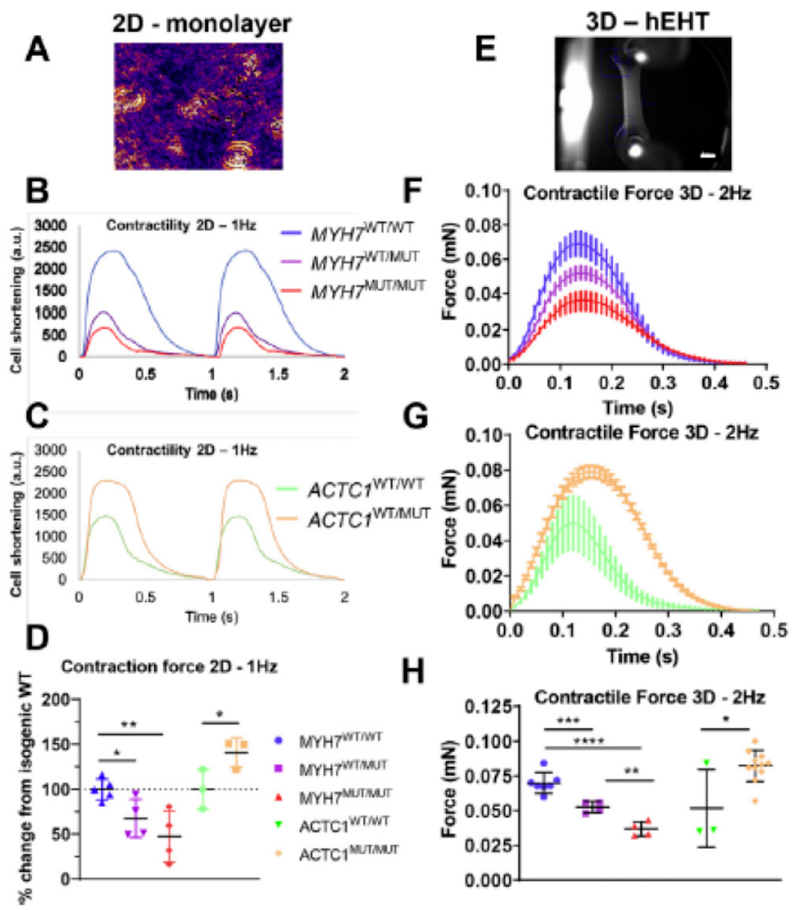
Figure 6. Results from experiments using hiPSC based preparations, illustrating both hypo- and hypercontractility in response to HCM-causing mutations and greater effects with homozygous mutations. ( A ) Micrograph illustrating hiPSC-derived cardiomyocytes of the type used for analyses in panels ( B , C ). ( B ) Representative recordings of cardiomyocyte shortening showing a hypocon- tractile phenotype for the β -MHC R453C mutation (MUT) compared to isogenic wild-type (WT) controls. Note that the hypocontractility was more severe with mutation homozygosity (MUT/MUT). ( C ) Similar recordings as in (B), showing a hypercontractile phenotype for the actin E99K heterozy- gous mutant. ( D ) Quantitative data for maximum cell shortening, as exemplified by recordings in ( B , C ), from 3–5 independent biological replicates. ( E ) Engineered heart tissue (hEHT) attached to silicon posts (scale bar = 1 mm) used for results in ( F – H ). ( F ) Twitch time courses (mean ± stan- dard deviation) recorded from hEHTs, using electrical stimulation at 2 Hz. The hEHT contained engineered cardiomyocytes with β -MHC R453C mutation (heterozygous = WT/MUT; homozygous = MUT/MUT) or isogenic wild-type control cardiomyocytes (WT/WT). Note the hypocontractile phenotype with mutation. ( G ) Twitch time courses as in ( F ) but for hEHT heterozygous for the actin E99K mutation or with isogenic wild-type cardiomyocytes showing a hypercontractile phenotype. ( H ) Quantitative data for maximum hEHT force development, as exemplified by recordings in ( F , G ), from 3 to 11 independent biological replicates. Asterisks in ( D , H ) refer to statistical significance levels: * p < 0.05, ** p < 0.01, *** p < 0.001, **** p < 0.0001. Reproduced from Reference [32], under a CC-BY license (http://creativecommons.org/licenses/BY/4.0/) accessed on 18 January